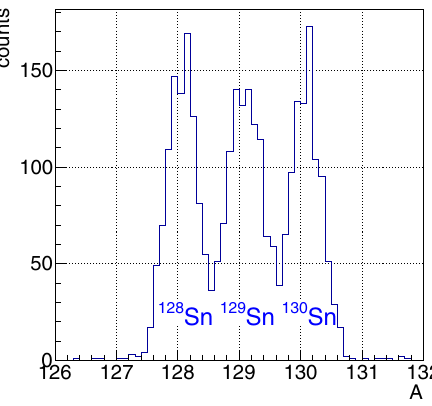
Figure 4. Distribution of the reconstructed mass of heavy fragments. Three peaks have su ffi cient